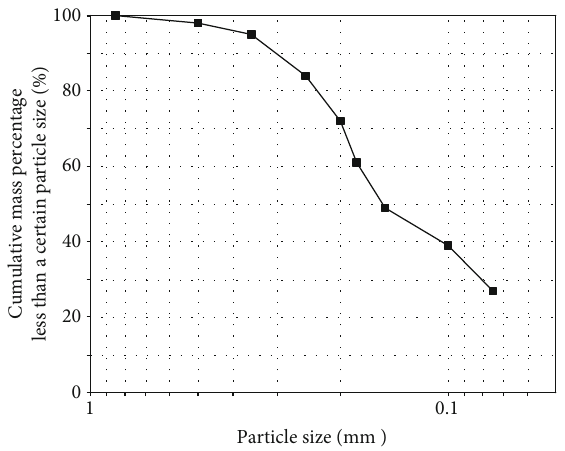
Figure 1: Tailings sand grain composition